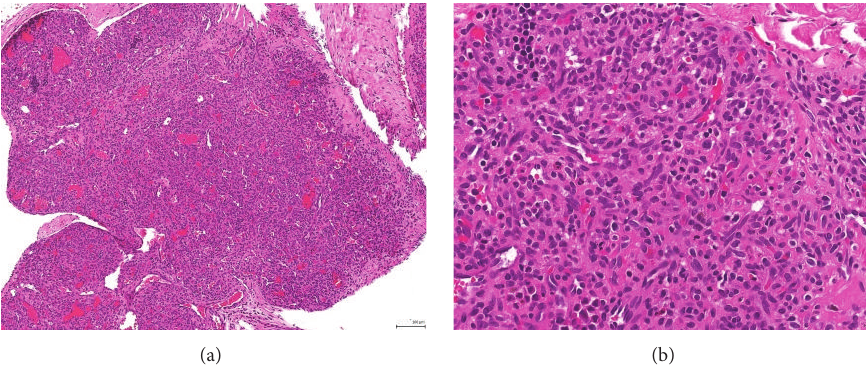
Figure 3: (a) Lobulated proliferation of small irregular capillary-sized vascular channels. (b) The lining endothelial cells are bland looking with no cytological atypia.